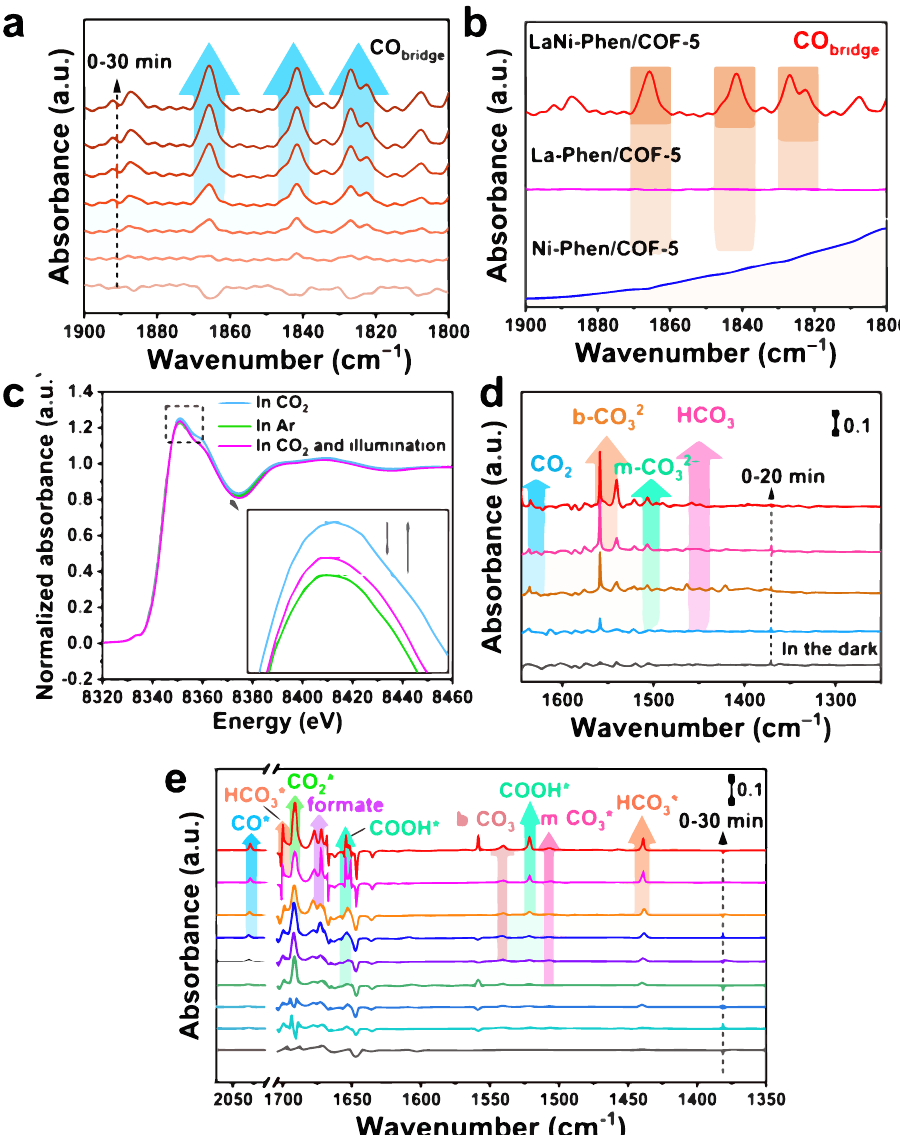
Fig. 5 | Detectionofthe reactionmechanismfor the photoreduction of CO 2 to CO. a In situ DRIFTS spectra of adsorbed CO at 1800 – 1900 cm − 1 for detecting the effective active site over LaNi-Phen/COF-5. b DRIFTS spectra of adsorbed CO at 1800 – 1900 cm − 1 over La-Phen/COF-5, Ni-Phen/COF-5, and LaNi-Phen/COF-5. c Ni K-edge XANES spectra of LaNi-Phen/COF-5 in CO 2 photoreduction reduction reaction at room temperature and 1atm of Ar or CO 2 -saturated aqueous solution